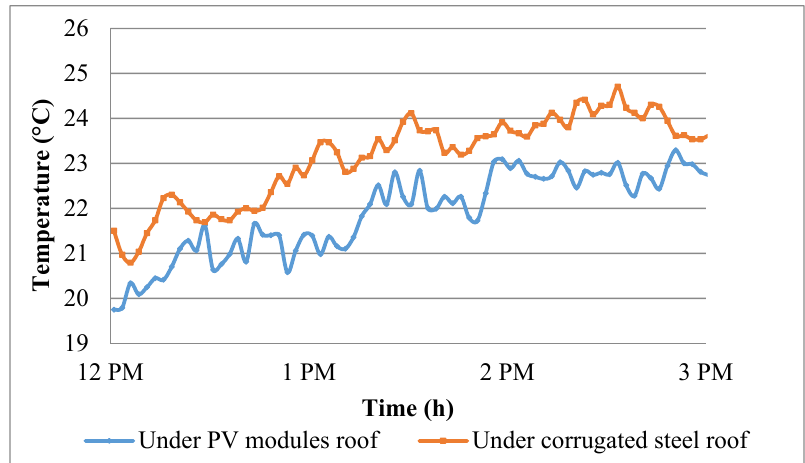
Figure 19. The comparison of temperatures under the roof and under photovoltaic module.